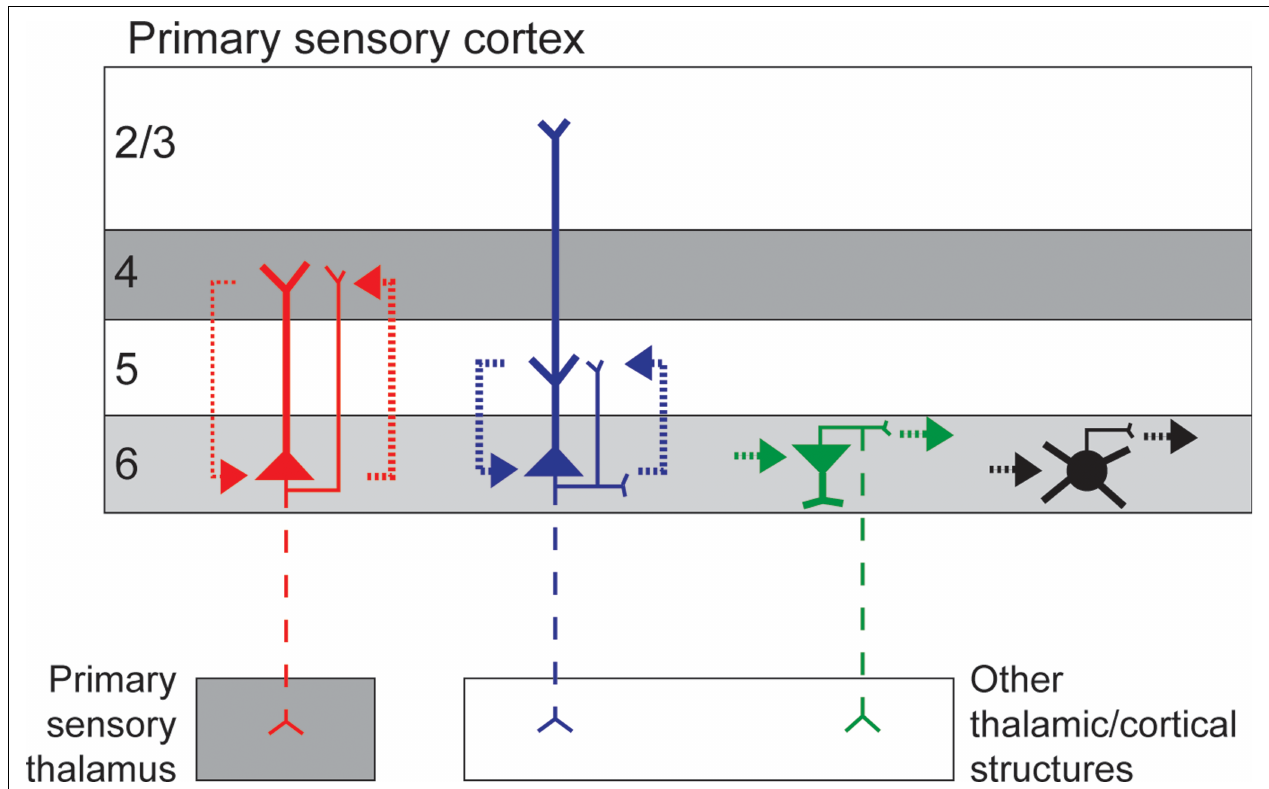
FIGURE 1 | Simplifi ed schematic of the circuitry of different neuronal types in layer 6 of primary sensory cortex. Short and tall pyramidal neurons are illustrated in red and blue, respectively, other excitatory neurons are represented in green, and inhibitory neurons represented in black. Dendrites are thick and